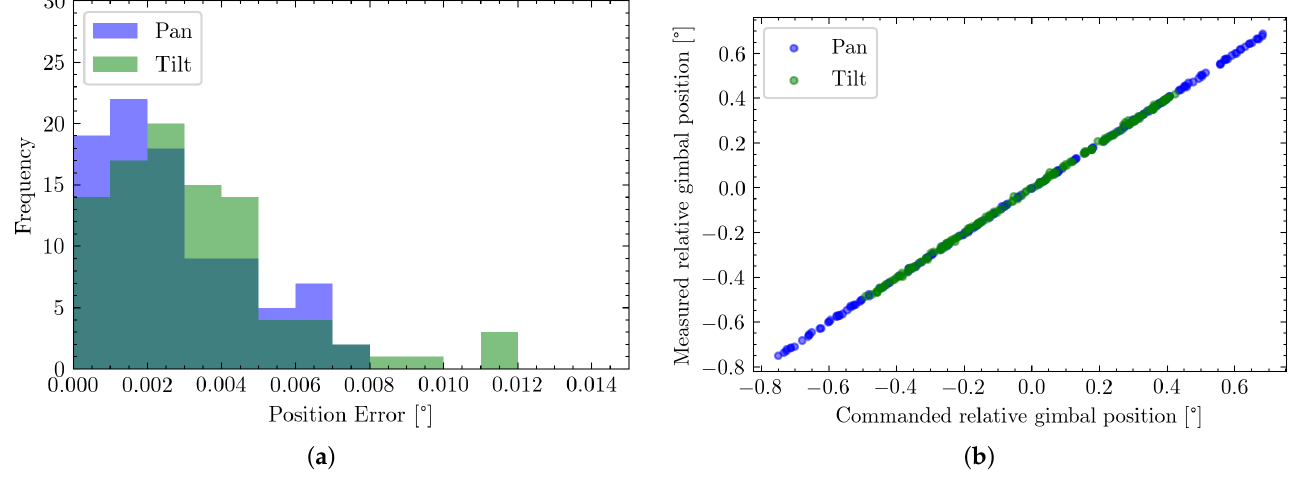
Figure 12. Evaluating error distribution and system linearity for both the pan (blue) and tilt (green) axis. ( a ) Histogram of error distribution along the individual axis; ( b ) Linearity of com- manded position to the measured